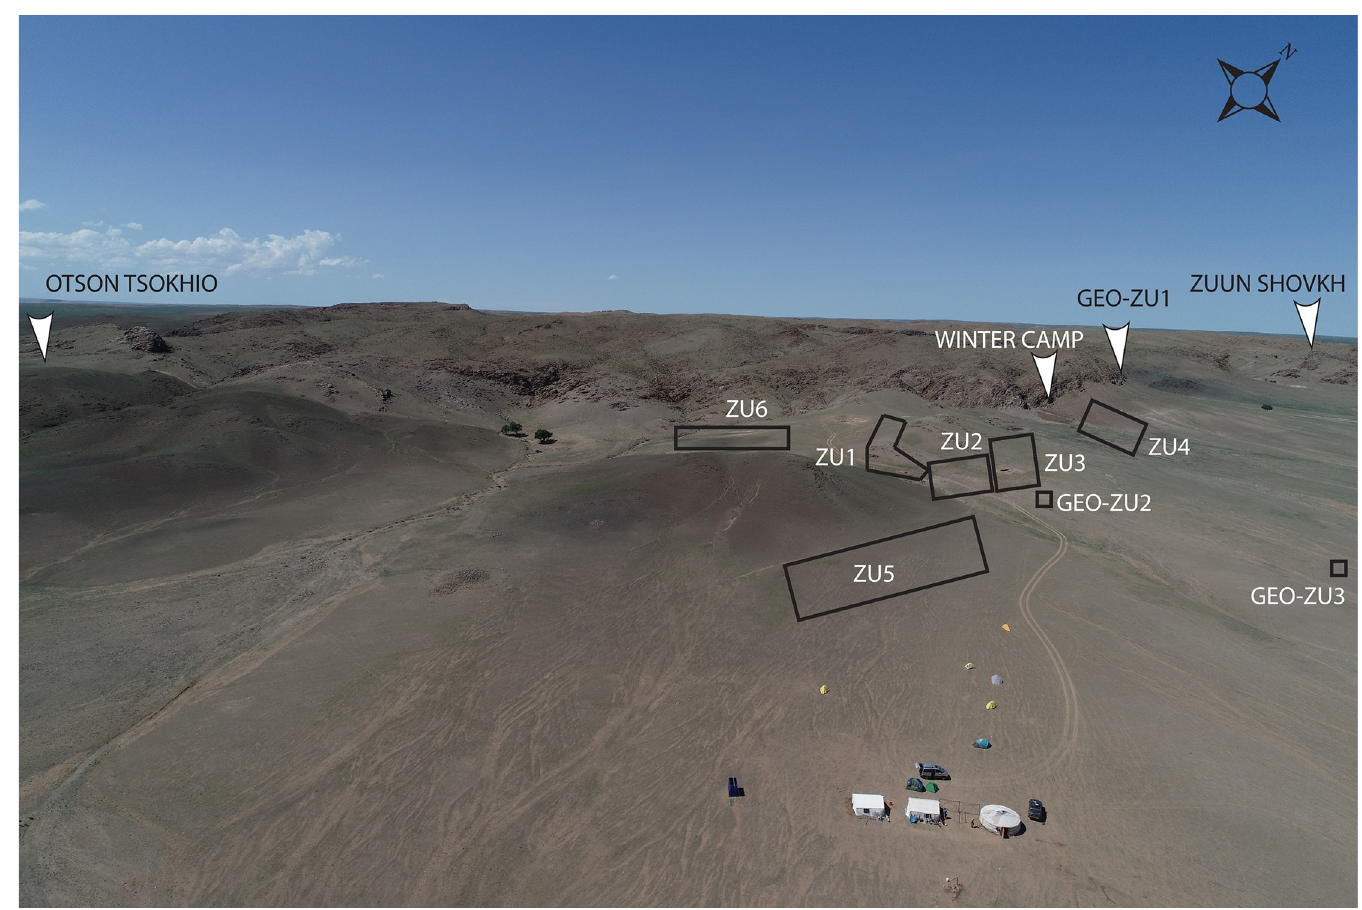
Fig 3. Aerial photograph of locality with location of sites and geopits. Drone image is property of Gobi-Steppe Neolithic Project, 2018.